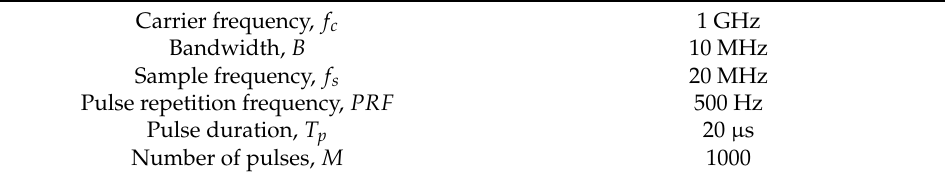
Table 2. Simulation parameters of radar.